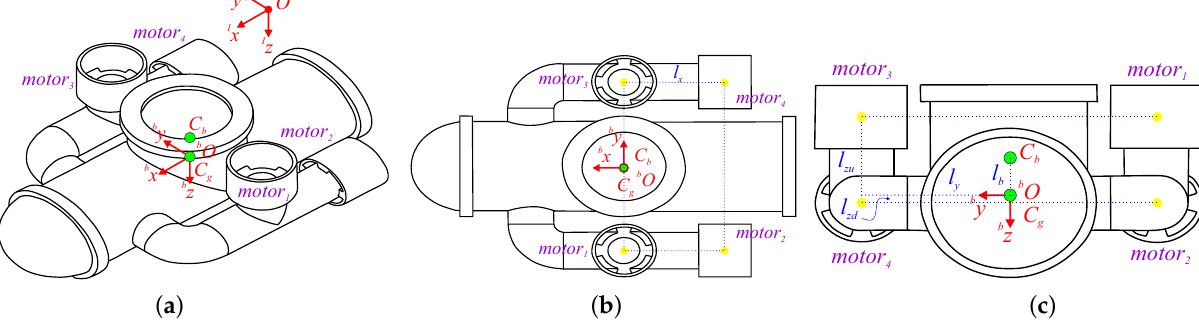
Figure 1. Mini-autonomous underwater vehicles (AUV): ( a ) Isometric view. ( b ) Top view. ( c ) Frontal view. The maximal dimensions of the vehicle (established as 0.6 × 0.42 × 0.24 m in b x , b y , and b z , respectively) place it in the “mini vehicle” category [23,41]. According to the CAD software that was used for its conception (Solidworks™), the volume of the mini- AUV is 0.006 m 3 , which in conjunction with its mass, m = 7.5 kg, defines the principal moments of inertia about the axis b x , b y , and b z as I x = 0.11 kg · m 2 , I y = 0.199 kg · m 2 , and I z = 0.251 kg · m 2 ,